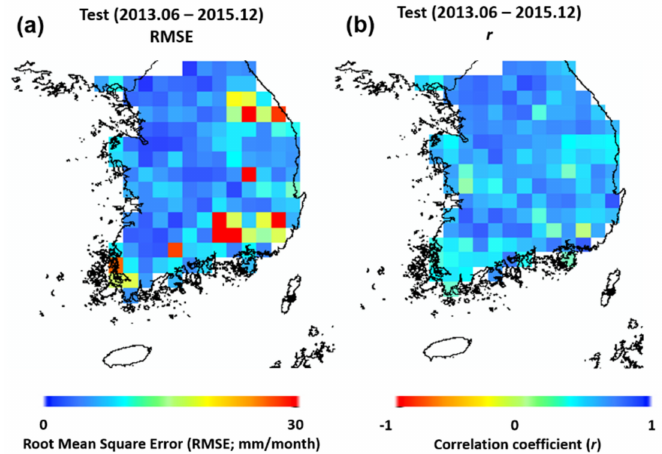
Figure 6. Spatial distribution of ( a ) RMSE and ( b ) correlation coe ffi cient between